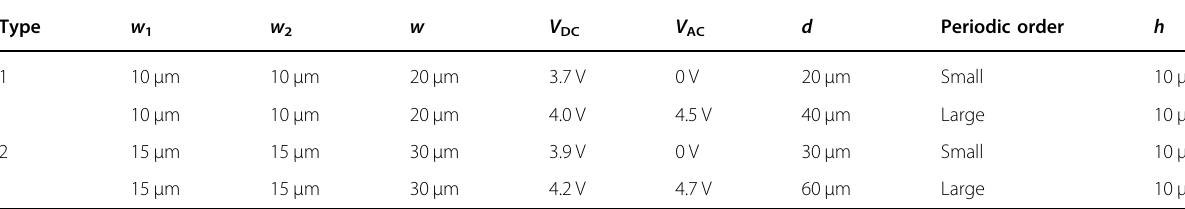
Table 1 Parameters of the different tunable liquid crystal gratings Type w 1 w 2